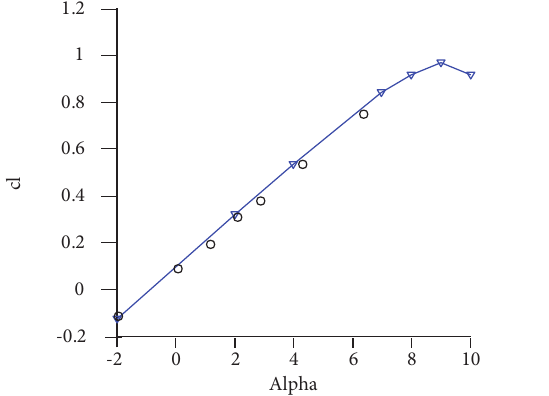
Figure 11. Lift coefficient distribution, Mach = 0.4.